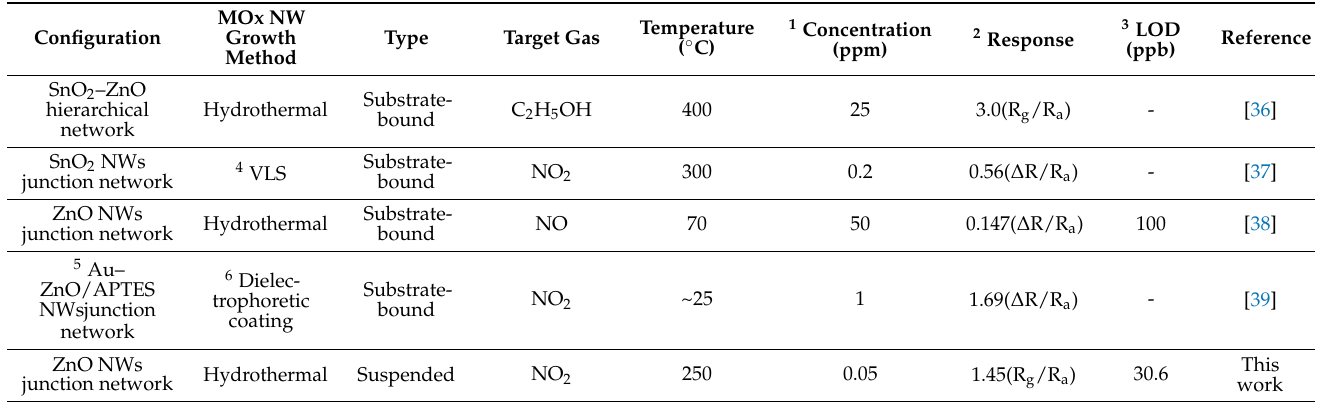
Table 1. Summary of the sensing performances of gas sensors based on MOx NW junctions.